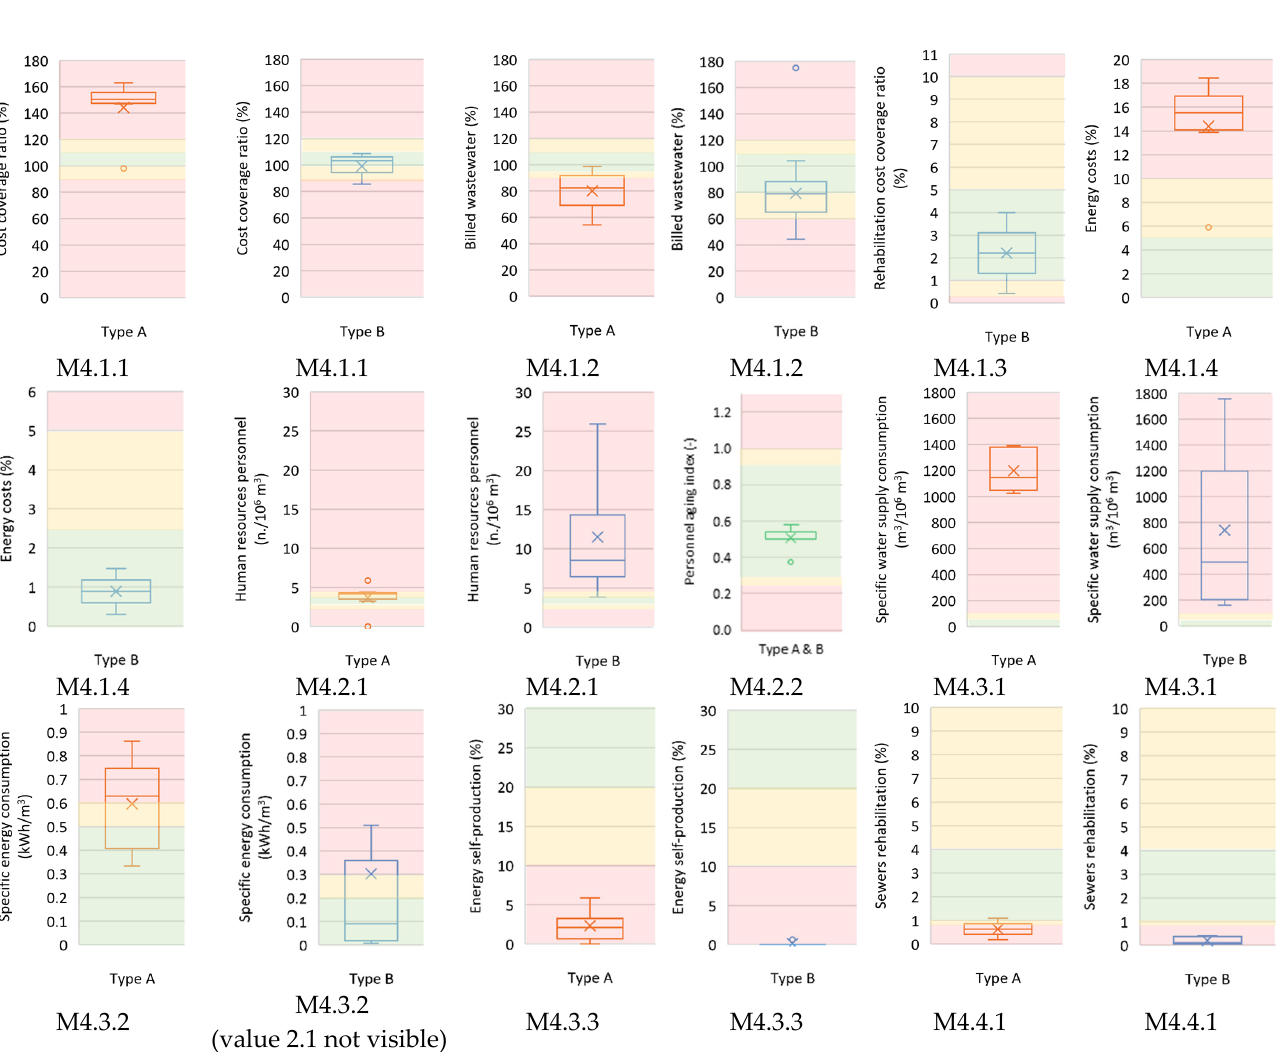
Figure 8. Results of the validation applied to the wastewater utilities: objective 4.